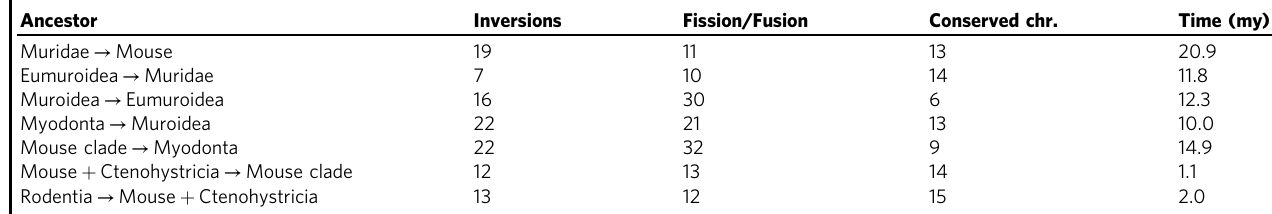
Table 2 Number and type of chromosome rearrangements between reconstructed rodent ancestors. Ancestor Inversions Fission/Fusion Conserved